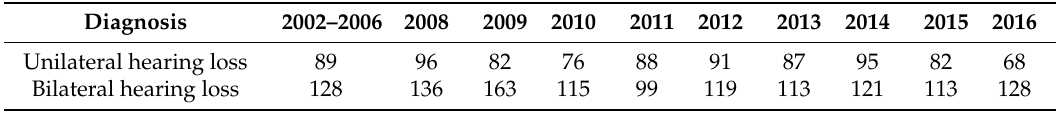
Table 4. Number of diagnoses of unilateral and bilateral hearing loss 2002/2006–2016.